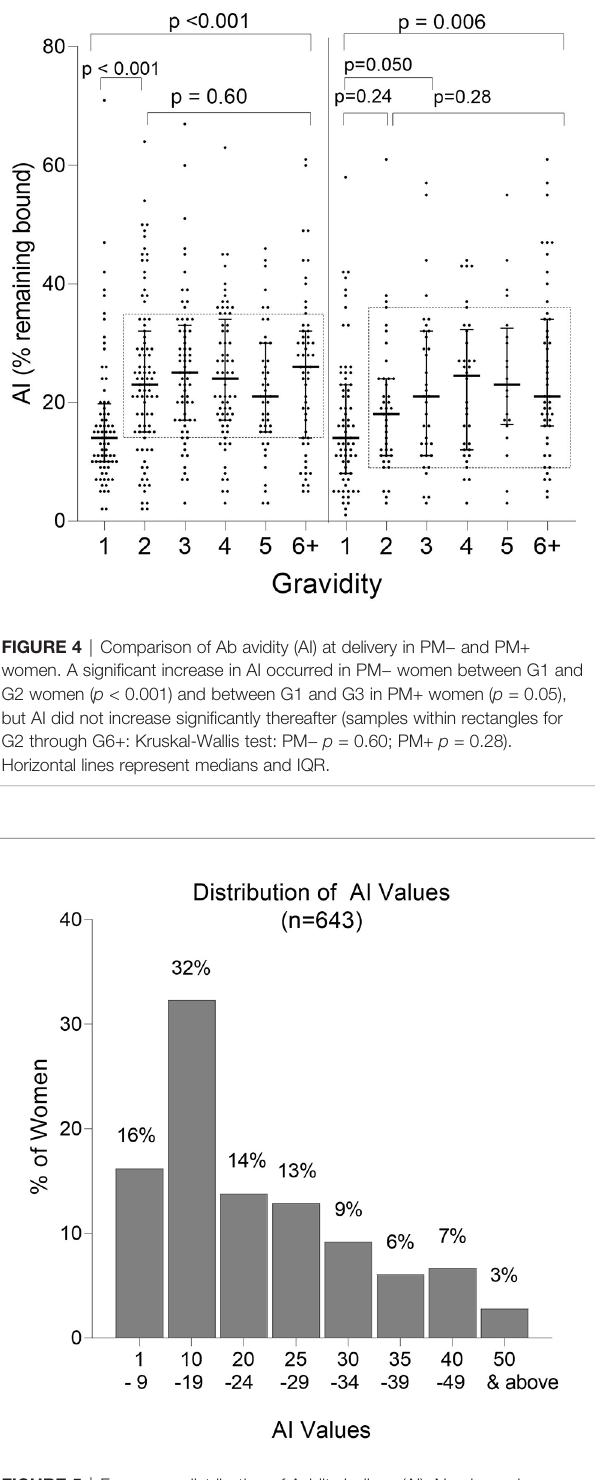
FIGURE 5 | Frequency distribution of Avidity Indices (AI). Numbers above each column are the percentage of samples in the AI category. n = 643